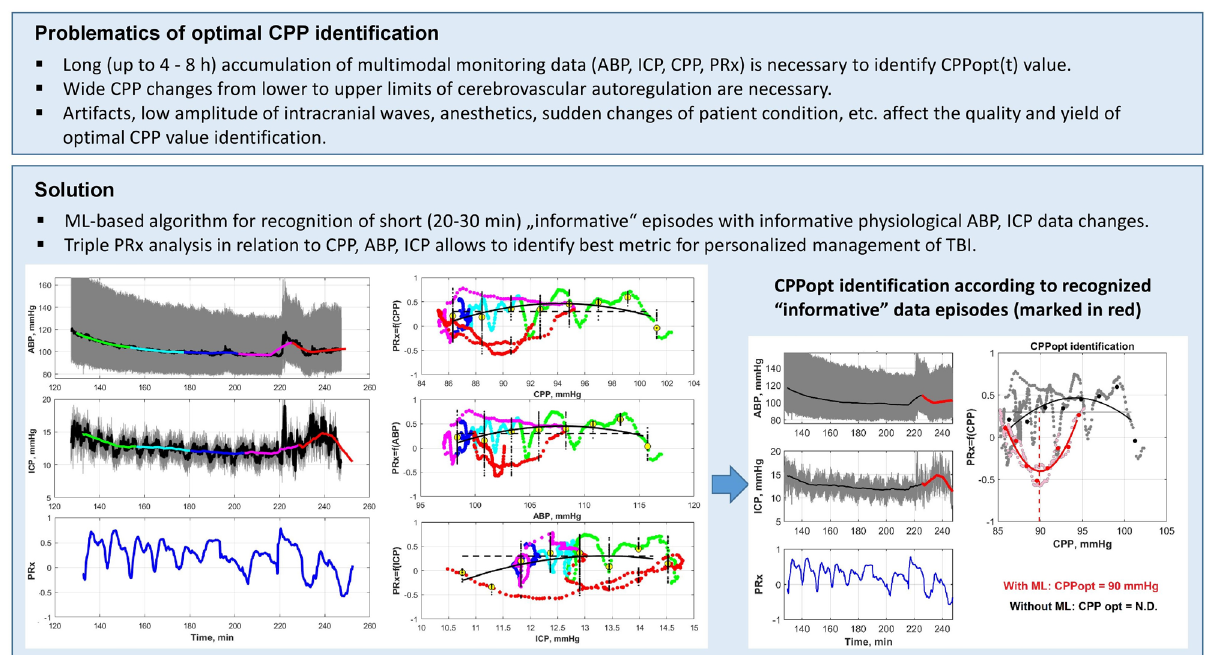
Figure 1. Problematics of CPPopt value identification and research idea. Machine learning (ML)-based algorithms are applied to recognize the informative physiological ABP/ICP variations within short (20–30 min) intervals and use these data episodes for the timely identification of optimal value (or lower/upper CA limits) in CPP, ABP or ICP data. CPPopt(t) value is identified according to recognized “informative” data episodes (marked in red) as a minimum point of “U-shape” approximation in PRx = f(CPP) graph. Outcome p value Favorable vs. unfavorable Fatal vs. survival(GOS =